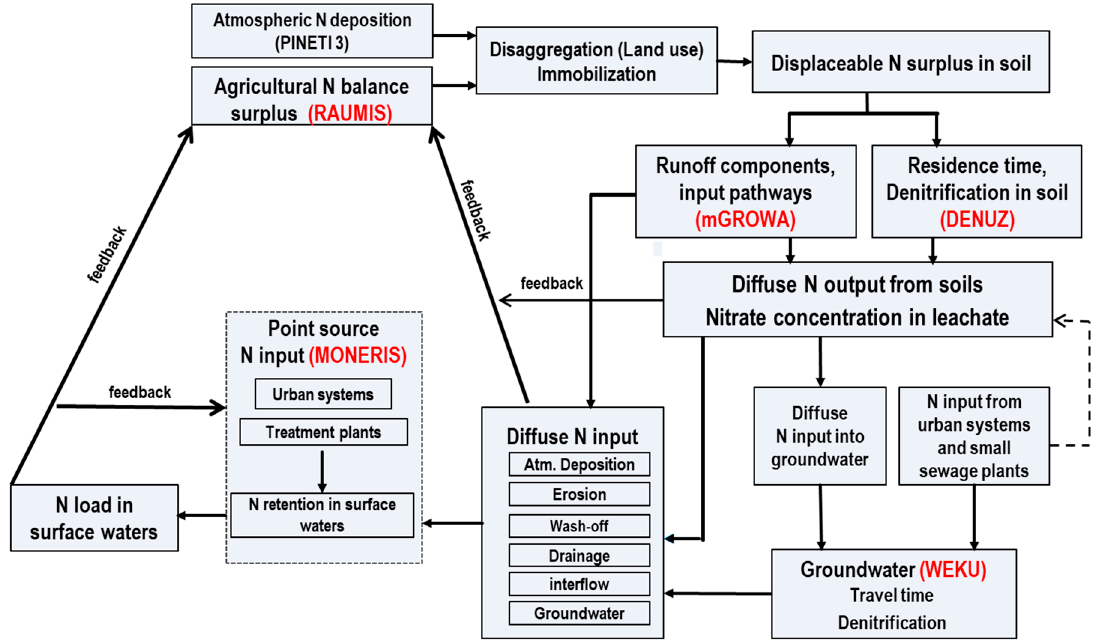
Figure 1. Simulation of nitrate concentration in the leachate in the framework of the coupled model system RAUMIS-mGROWA-DENUZ-WEKU-MONERIS.